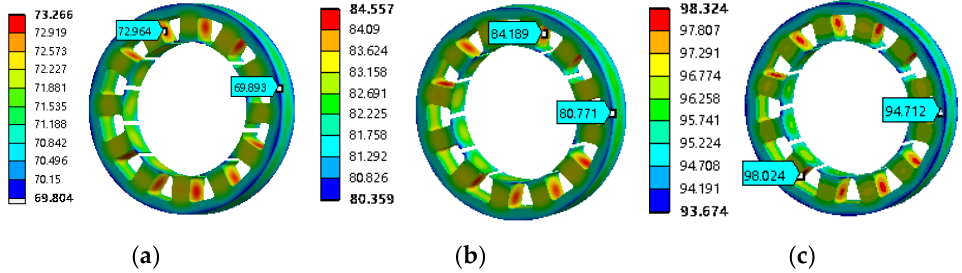
Figure 14. The steady-state temperature distribution of DHEG stator core at 3000 rpm: ( a ) 1 A; ( b ) 2 A; ( c ) 4 A.